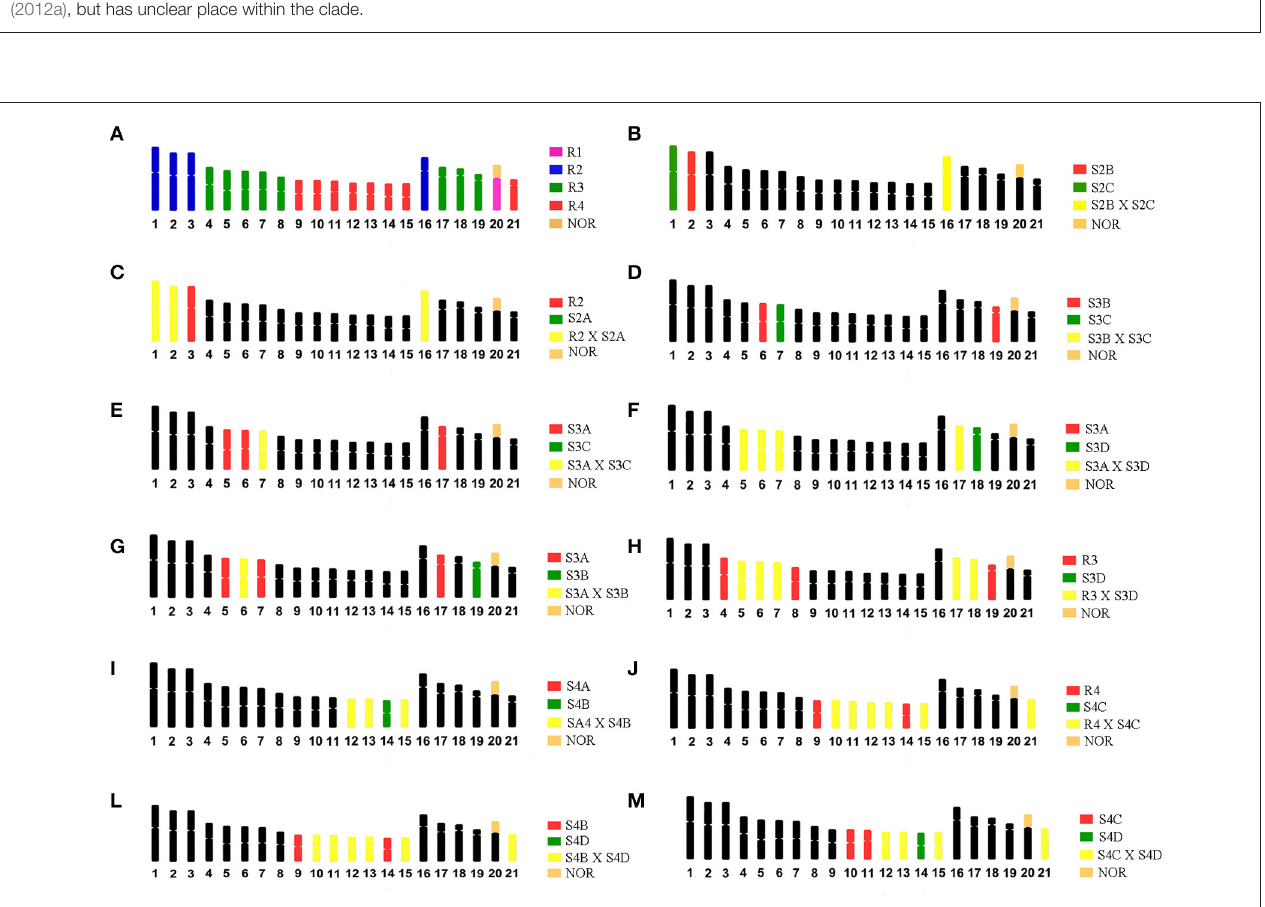
FIGURE 2 | Ideograms of the karyotype of G. carapo (2 n = 42) representing: (A) The four chromosome regions (R1, R2, R3, R4) obtained by Nagamachi et al. (2010). (B–M) Dual – color FISH experiments based on Nagamachi et al. (2010, 2013), to identify chromosomal homology with GCA (2 n = 42). S2A, S2B, and S2C represents sub-regions (A–C) within region 2; S3A, S3B, S3C, and S3D represents sub-regions (A–D) within region 3; S4A, S4B, S4C, and S4D represents sub-regions (A–D) within region 4.